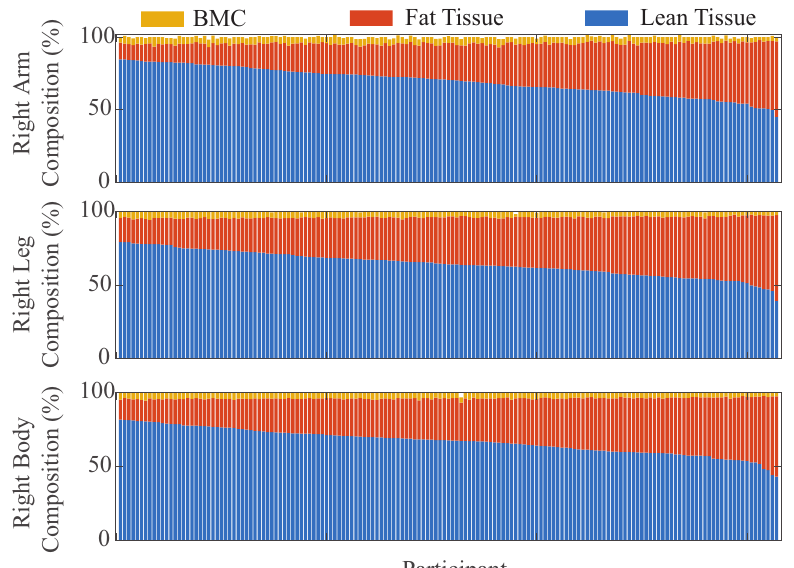
Figure 8. DXA derived contributions of bone mineral content (orange), fat tissue (red), and lean tissue (blue) to overall composition of right arm, right leg, and right body of study